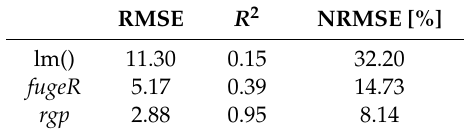
Table 3. Summary of ED prediction performance for models created with different methods.